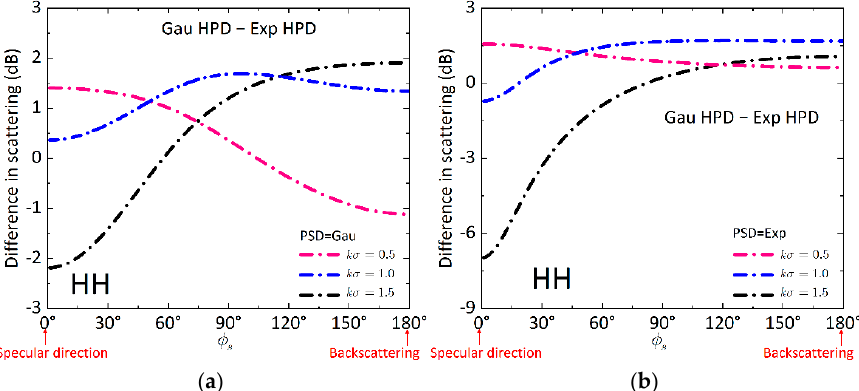
Figure 5. Difference of incoherent scattering as function of scattering azimuthal angle between the Gaussian and exponential HPD rough surfaces with Gaussian and exponential PSDs at kl = 8, ε r = 15 − j 1.5, θ i = 20 ◦ , θ s = 20 ◦ . ( a ) Gaussian PSD, ( b ) exponential PSD.